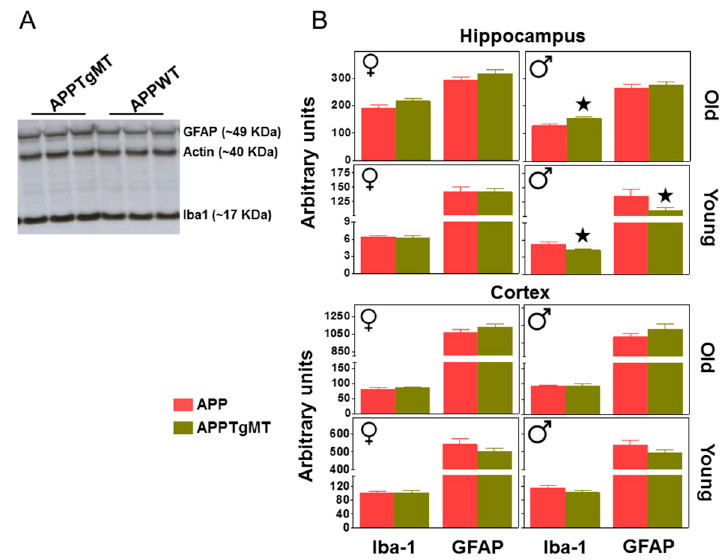
Figure 4. Effect of Mt1 overexpression on hippocampal gliosis as measured by western blot (WB). Total hippocampal and cortex homogenates were assayed by WB to further characterize gliosis. ( A ) Representative band pattern of the WB (in an autoradiographic film) of old male hippocampus using antibodies for GFAP, Iba-1, and Actin; ( B ) Quantification of hippocampal GFAP and Iba-1 levels in young and old APPWT and APPTgMT mice. Iba-1 levels were increased by Mt1 overexpression in old male mice but decreased in young males; the latter also showed decreased GFAP levels. Data are mean ± SEM ( n = 10–11). (cid:70) p at least ≤ 0.05 vs. APPWT mice. a.u., arbitrary units.